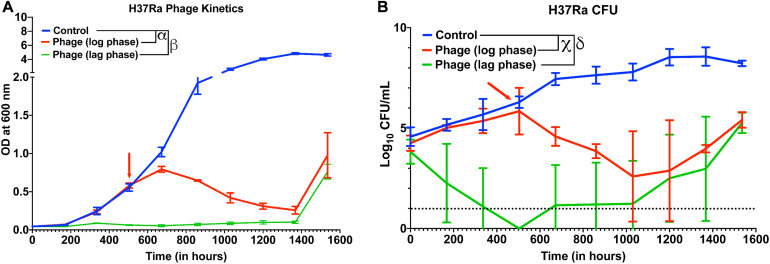
Phage cocktails are effective against M. tuberculosis. (A) Growth kinetics of M. tuberculosis (H37Ra) after treatment with a 3-phage cocktail (D29, Che7, and DS6A). Multiple t-test with Holm-Sidak method was used to estimate the statistical significance (p < 0.05). α represents a significant difference between control and phage treated group (log phase) for all time points between 672 and 1536 h. β represents a significant difference (p < 0.05) between control and phage treated group (lag phase) for all time points between 168 and 1536 h. (B) Colony Forming Unit (CFU) measurements over time of M. tuberculosis cultures treated with a 3-phage cocktail. χ represents a significant difference (p < 0.05) between control and phage (log phase) for all time points between 672 and 1536 h. δ represents a significant difference (p < 0.05) between control and phage (lag phase) for all time points between 168 and 1536 h. Multiple t-test with Holm-Sidak method was used to determine the statistical significance. The detection limit for the assay is represented in black dotted line (10 CFU).